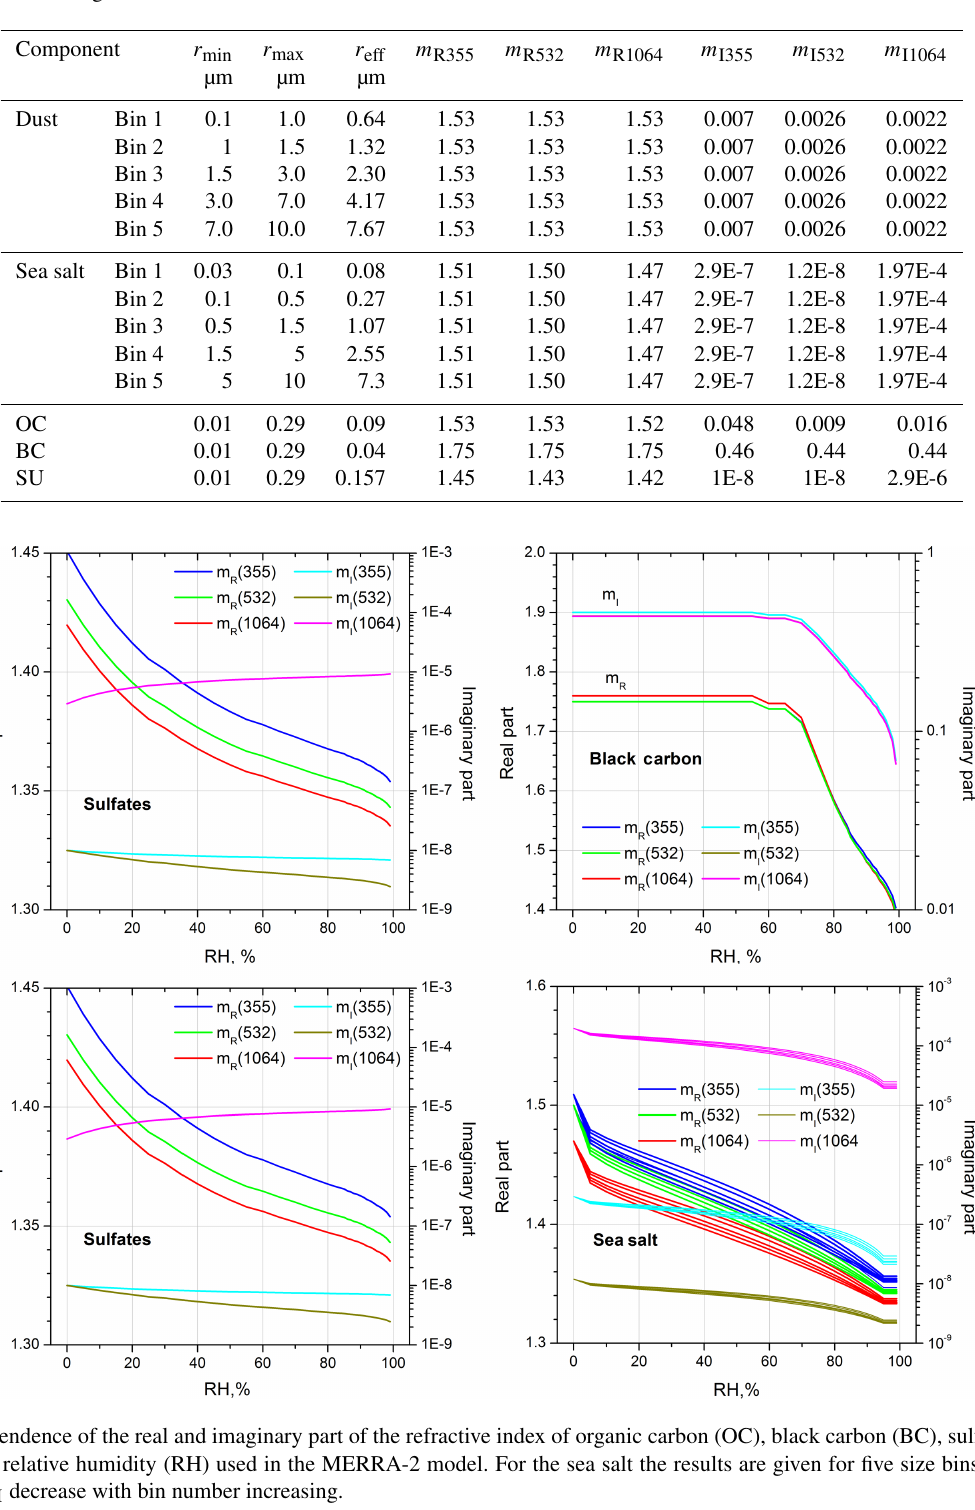
Table A1. Parameters of the aerosol components, such as minimal radius ( r min ), maximal radius ( r max ), effective radius ( r eff ), and real ( m R ) and imaginary ( m I ) part of the refractive index at 355, 532, and 1064nm used in MERRA-2 model. For dust and sea salt, five size bins are considered. All values are given for RH = 0.